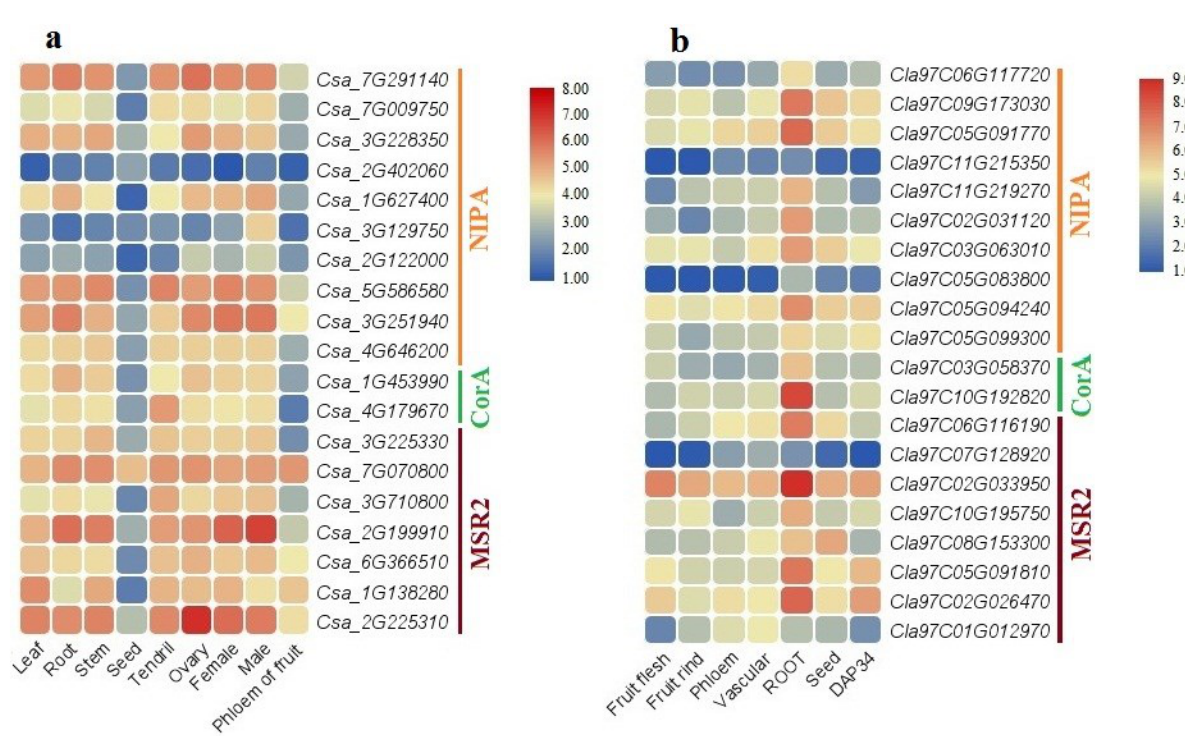
Figure 10. Heatmaps of expression of MGT genes respond to biotic and abiotic in C. lanatus ( a ) and C. sativus ( b ).